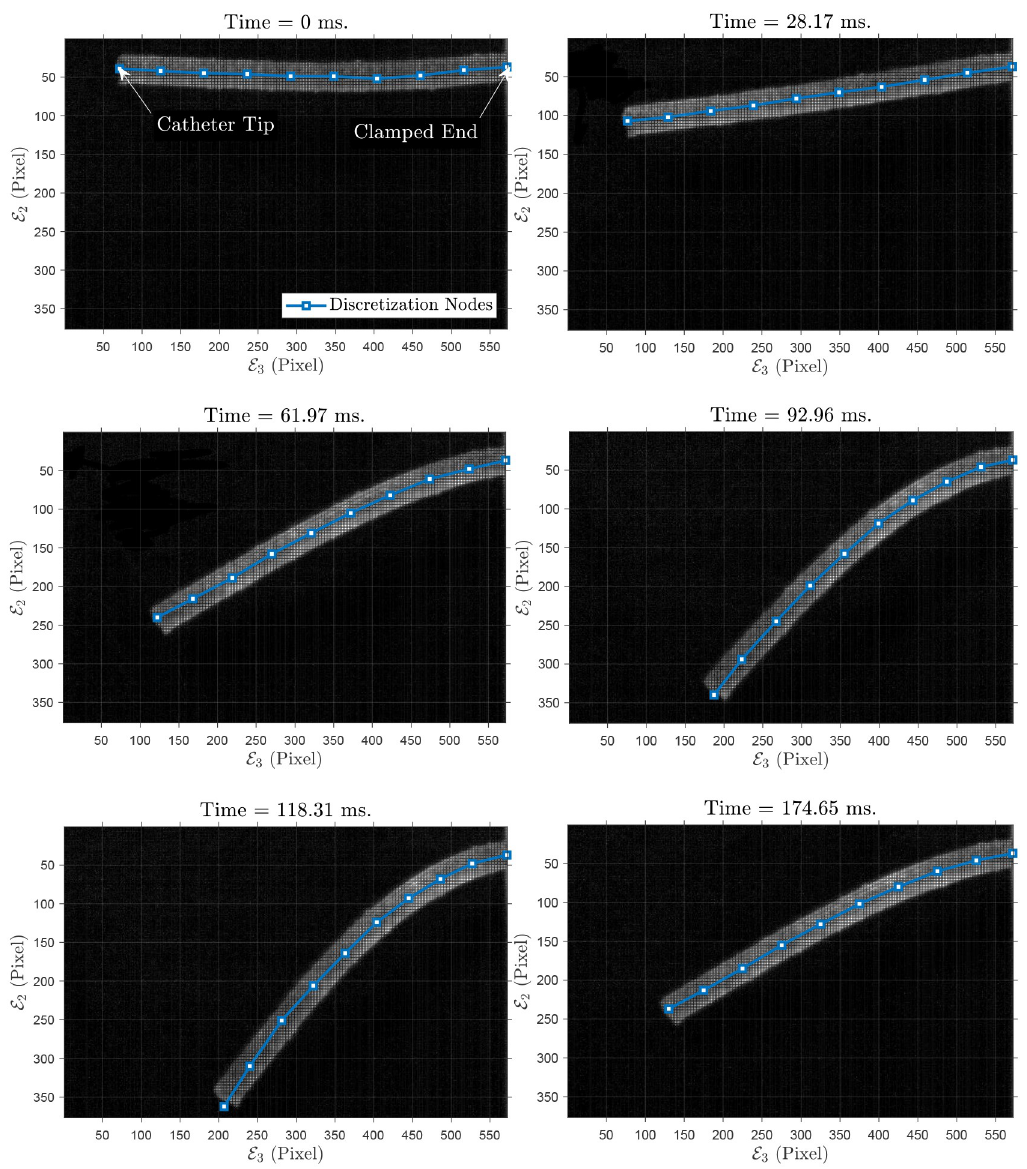
Fig 8. Sample of grabbed images for Polydimethylsiloxane (PDMS) rod without any embedded magnet in 2D experiment: In-plane motion. Also, 10 discretization points are superimposed on the soft rod.